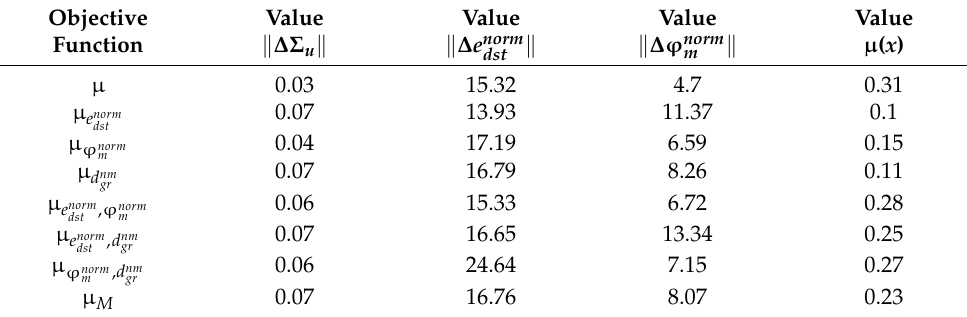
Table 3. The relative values of deviations of stress intensities (cid:107) ∆Σ u (cid:107) , (cid:107) ∆ e norm different definitions of the objective function µ ( x )